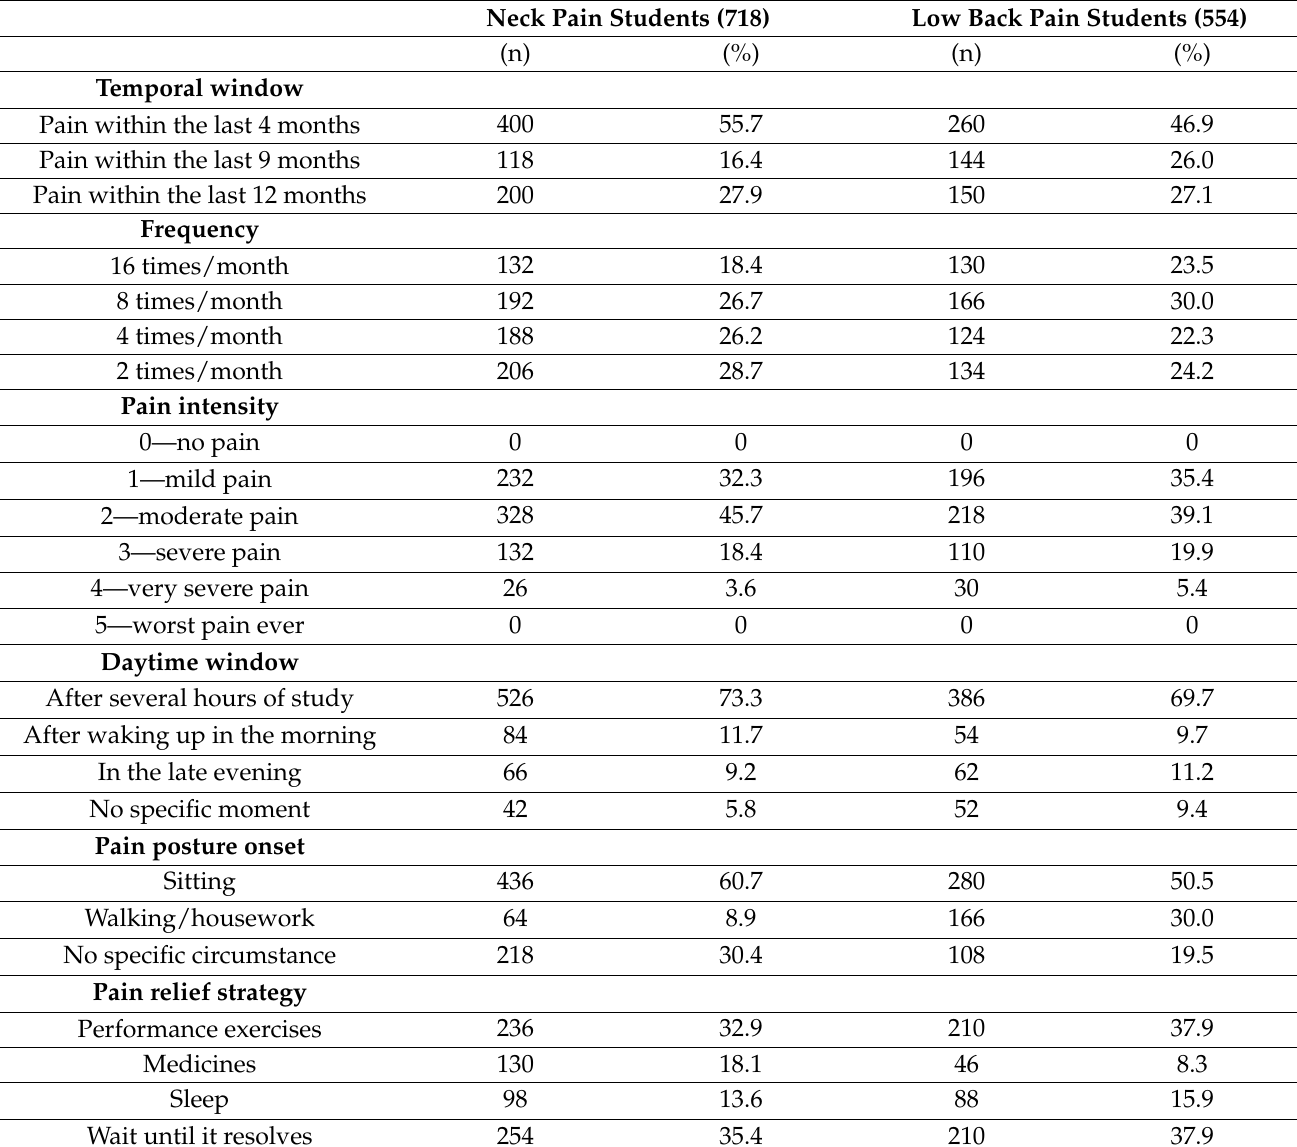
Table 4. Overall characteristics of musculoskeletal pains.